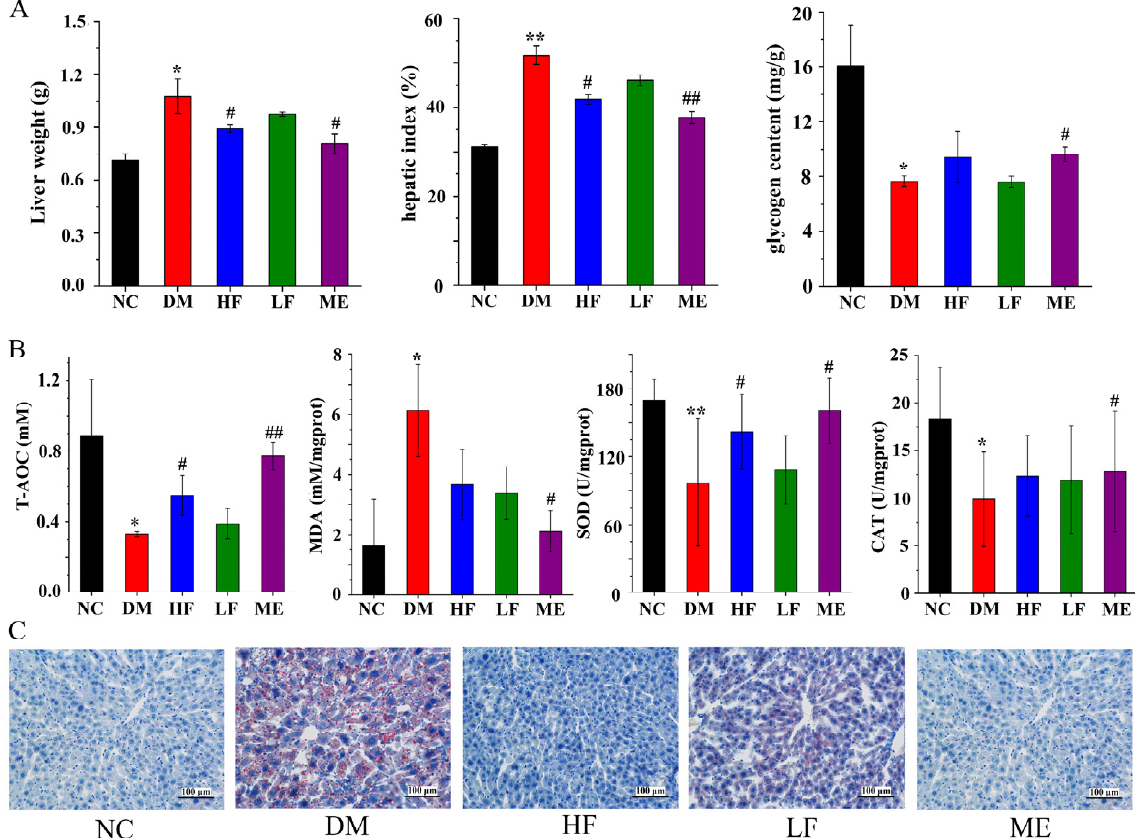
Figure 3. Protective effect of LJF on the liver: liver weight, hepatic index, and glycogen content ( A ); T-AOC, MDA, SOD, and CAT ( B ); histology analysis of liver by Oil-Red O dye staining ( C ). * p < 0.05 and ** p < 0.01 vs. NC group, and # p < 0.05 and ## p < 0.01 vs. DM group.